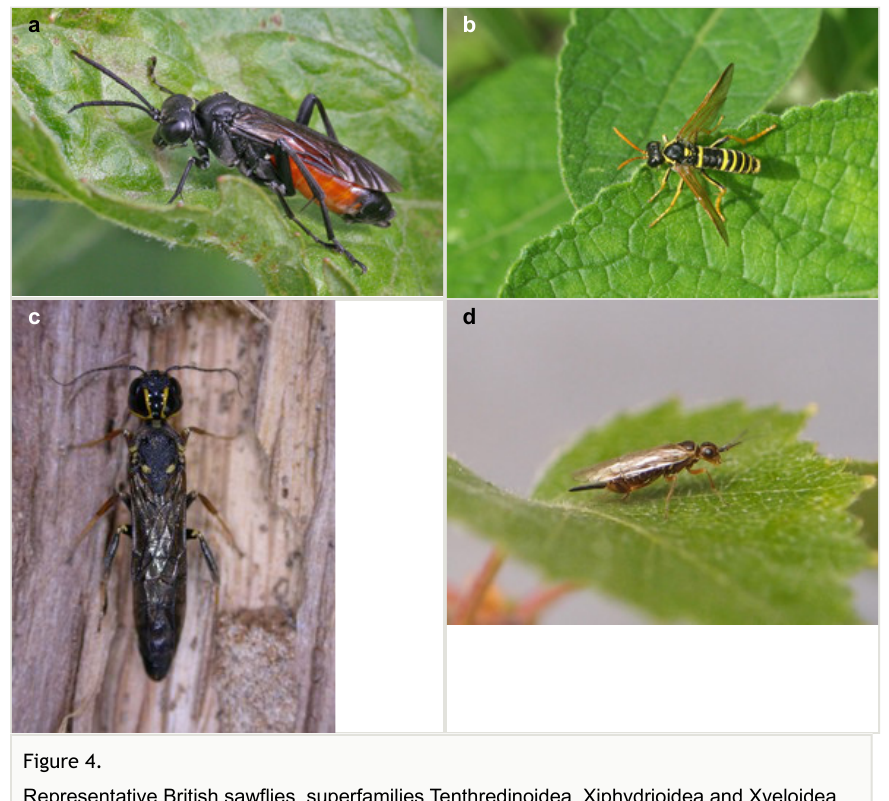
Figure 4. Representative British sawflies, superfamilies Tenthredinoidea, Xiphydrioidea and Xyeloidea. a : Tenthredinidae, Macrophya annulata (U. Rindlisbacher) b : Tenthredinidae, Tenthredo scrophulariae (H. Savina) c : Xiphydriidae, Xiphydria longicollis (F. Stergulc) d : Xyelidae, Xyela curva (G.